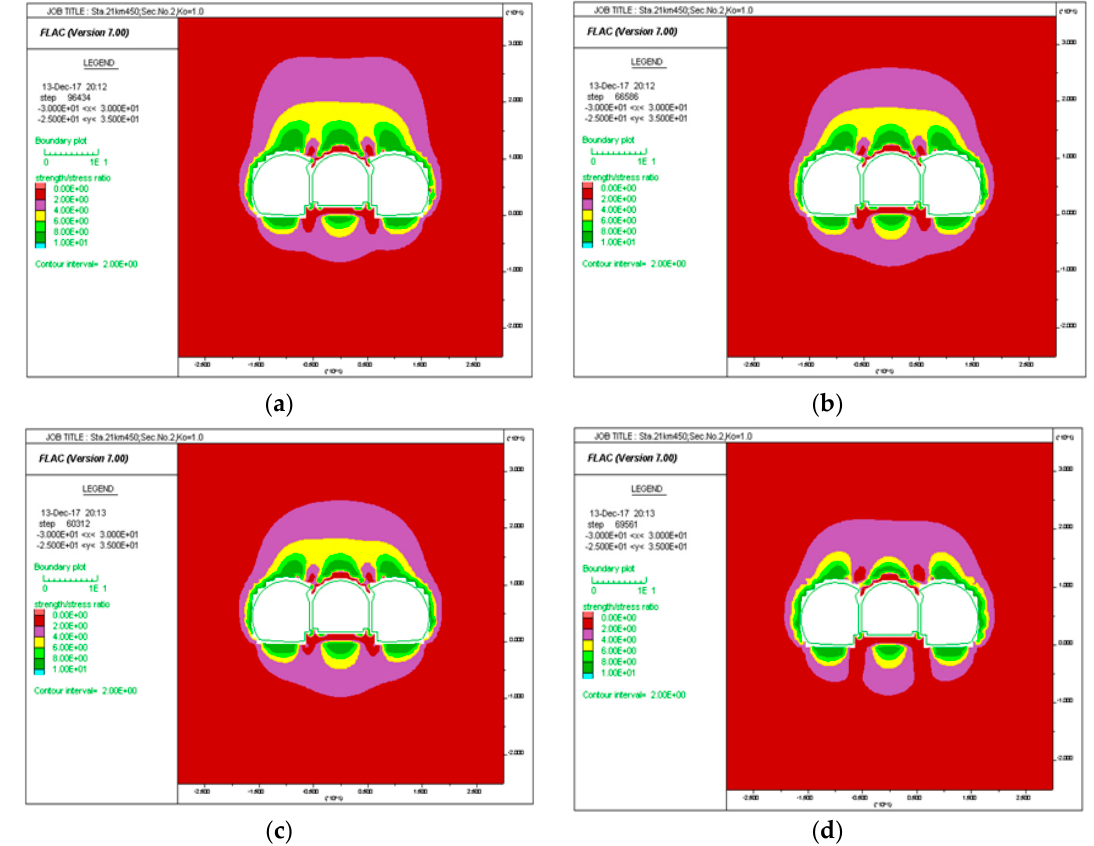
Figure 10. Estimation of rock load in terms of the stress variable of 10% in rock mass class III, ( a ) overburden = 40 m (1.3 D); ( b ) overburden = 50 m (1.7 D); ( c ) overburden = 60 m (2.0 D); ( d ) overburden = 70 m (2.3 D).